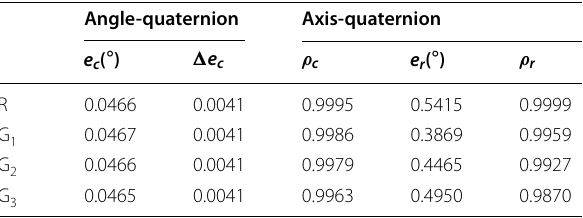
Table 2 Reachability and similarity of the generalized quaternion-based